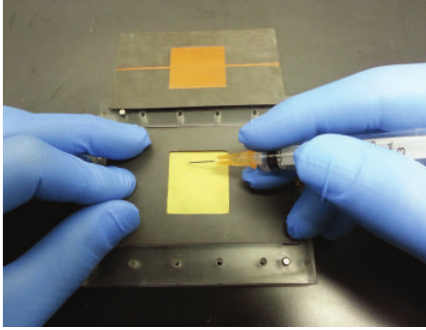
Figure 6: Fabricated S-band resonator, during liquid crystal (GT3- 23001) filling process [14].